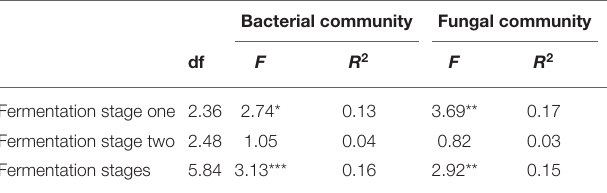
TABLE 1 | The effects of fermentation stages on the composition of bacterial and fungal communities. Bacterial community